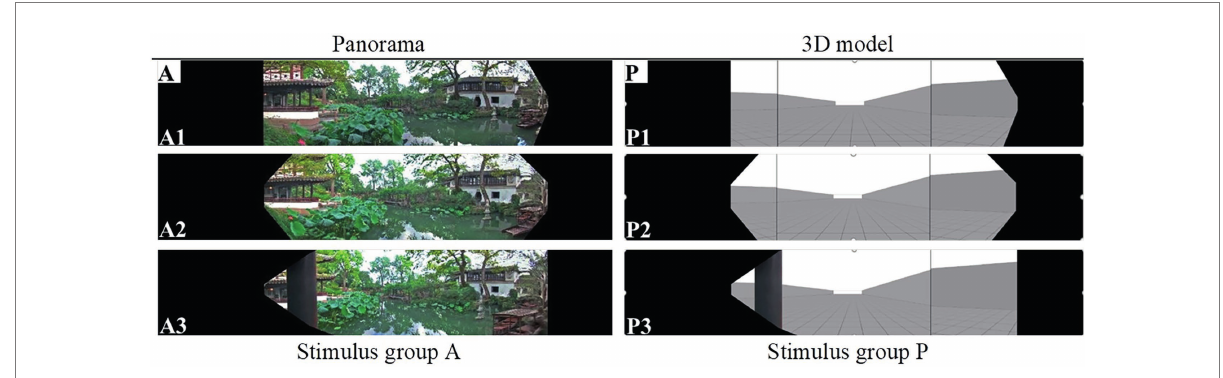
FIGURE 2 Example stimuli: panoramas and corresponding 3D models. (In each group, the pictures taken from the left, middle, and right positions are shown from top to bottom.)